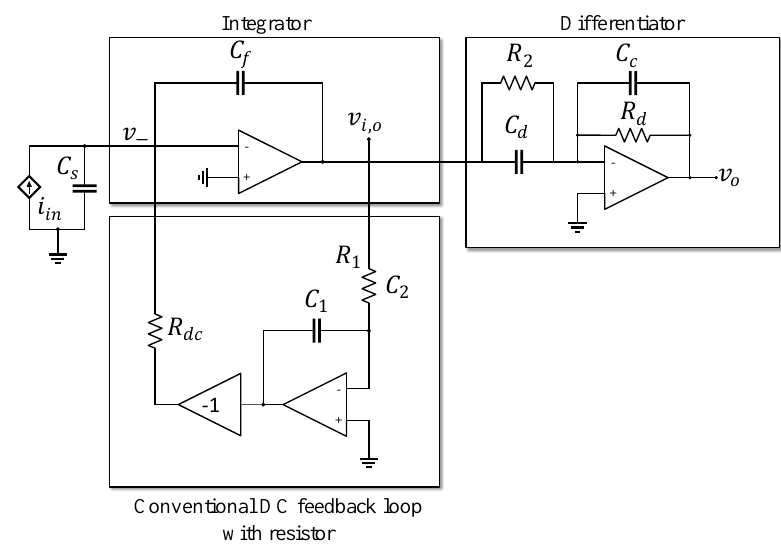
Figure 1. Capacitive Feedback Transimpedance Amplifier with conventional DC feedback